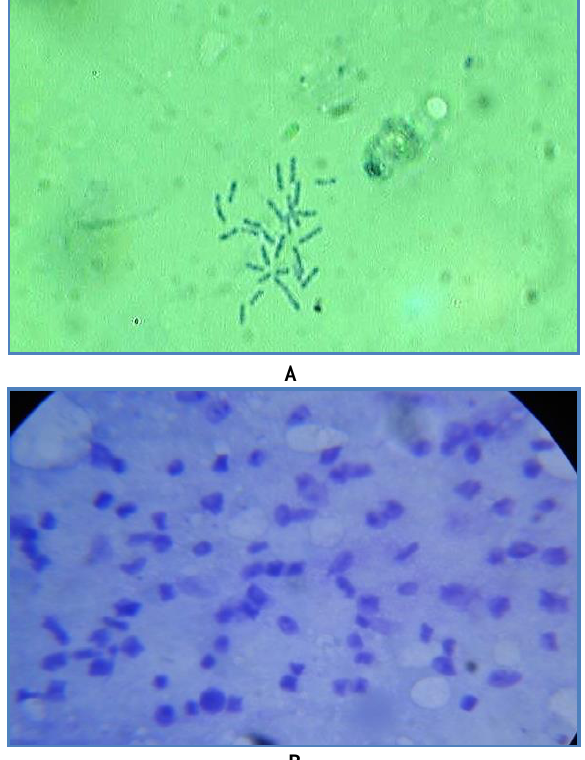
Figure, 1: A. Mitosis of chick embryo cells (Acridine stain under fluorescent microscope PH 1.9 X) B. Mitosis of chick embryo cells (Hoechest stain 100x under light microscope).